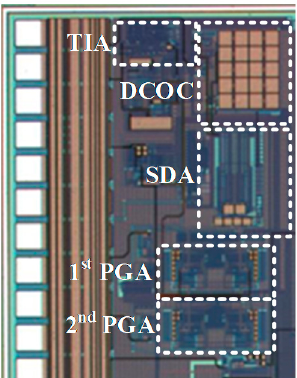
Figure 13. The chip-micrograph of the fine-dust detection system, including the proposed analog front-end and TIA.